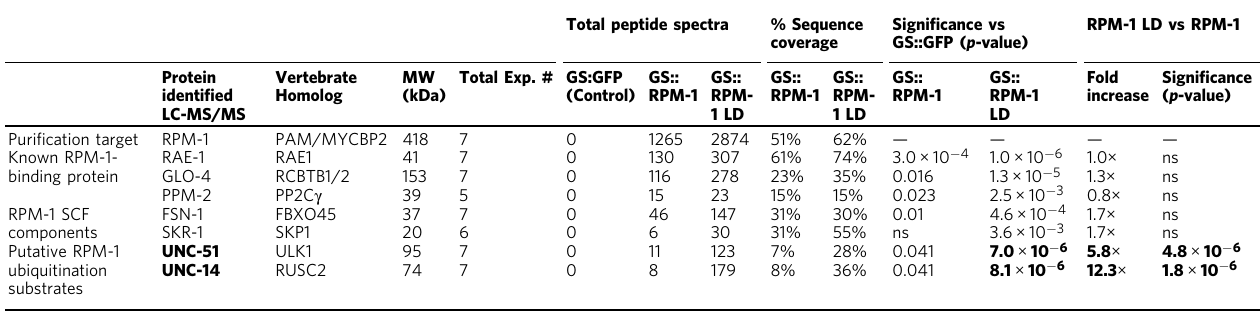
Table 1 Summary of af fi nity-puri fi cation proteomics data from C. elegans showing UNC-51 is a putative RPM-1 ubiquitination substrate